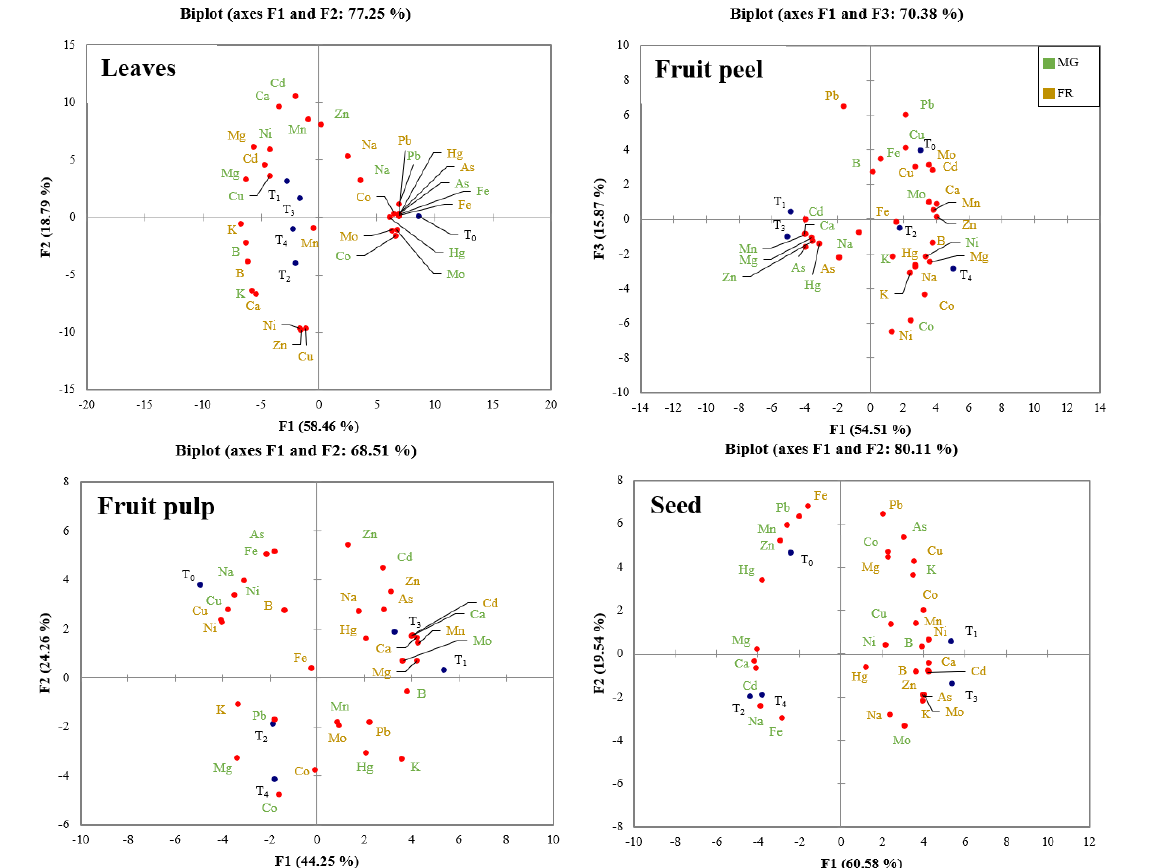
Figure 5. Principle component analyses (PCAs) comparing Mg, Zn, and B treatments (observations) and concentrations of phyto-nutritional elements in the leaves and fruit tissues of loquats. T 0 —control; T 1 —2% MgSO 4 · 7H 2 O, T 2 —0.1% ZnSO 4 · 7H 2 O, T 3 —0.2% Na 2 B 4 O 7 · 10H 2 O and T 4 —T 1 +T 2 +T 3 (1:1:1), MG—mature green stage, FR—fully ripe stage.